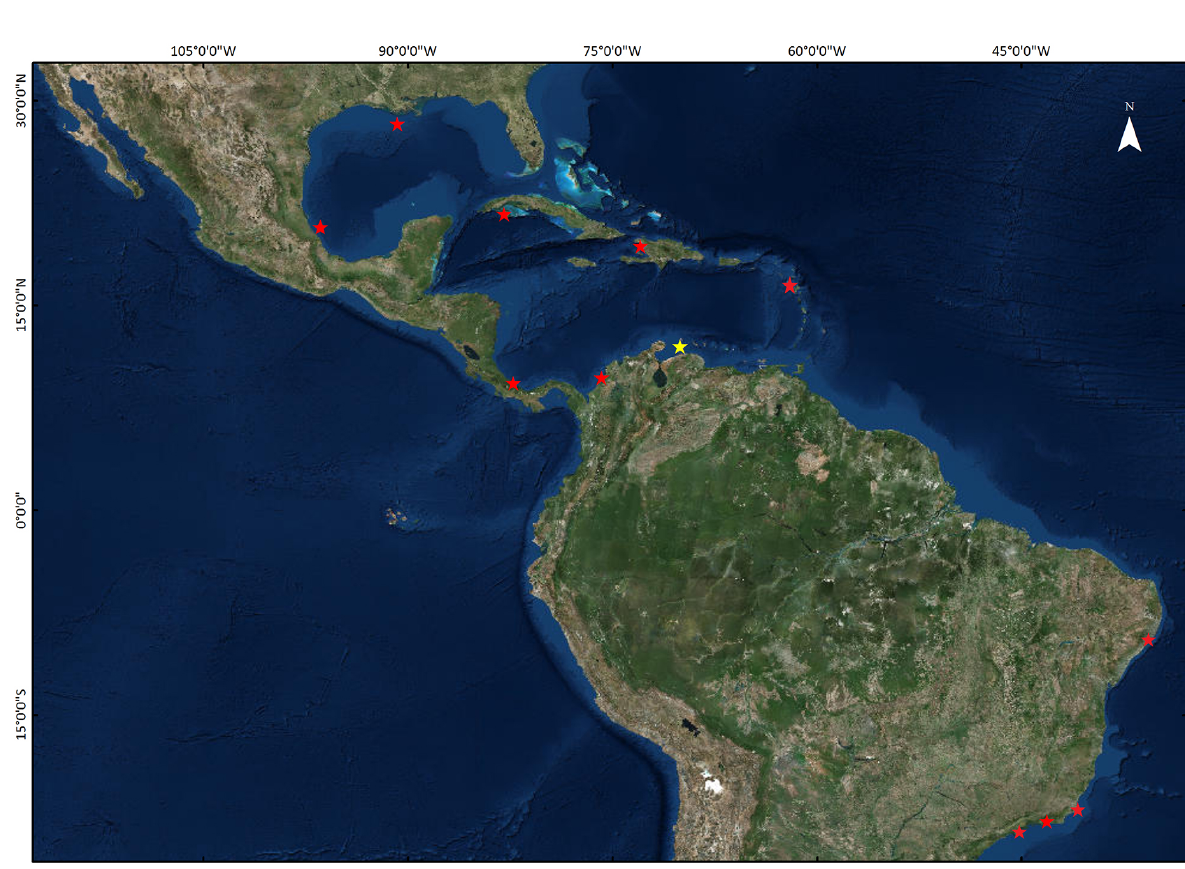
Figure 3. Distribution map of Alpheus platycheirus Boone, 1927 . The red stars correspond to localities of previous records (Bracken- Grissom and Felder, 2014; Bracken-Grissom et al. , 2014; Almeida et al. , 2018). The yellow star indicates the new record observed in the Paraguaná Peninsula, Venezuela (this